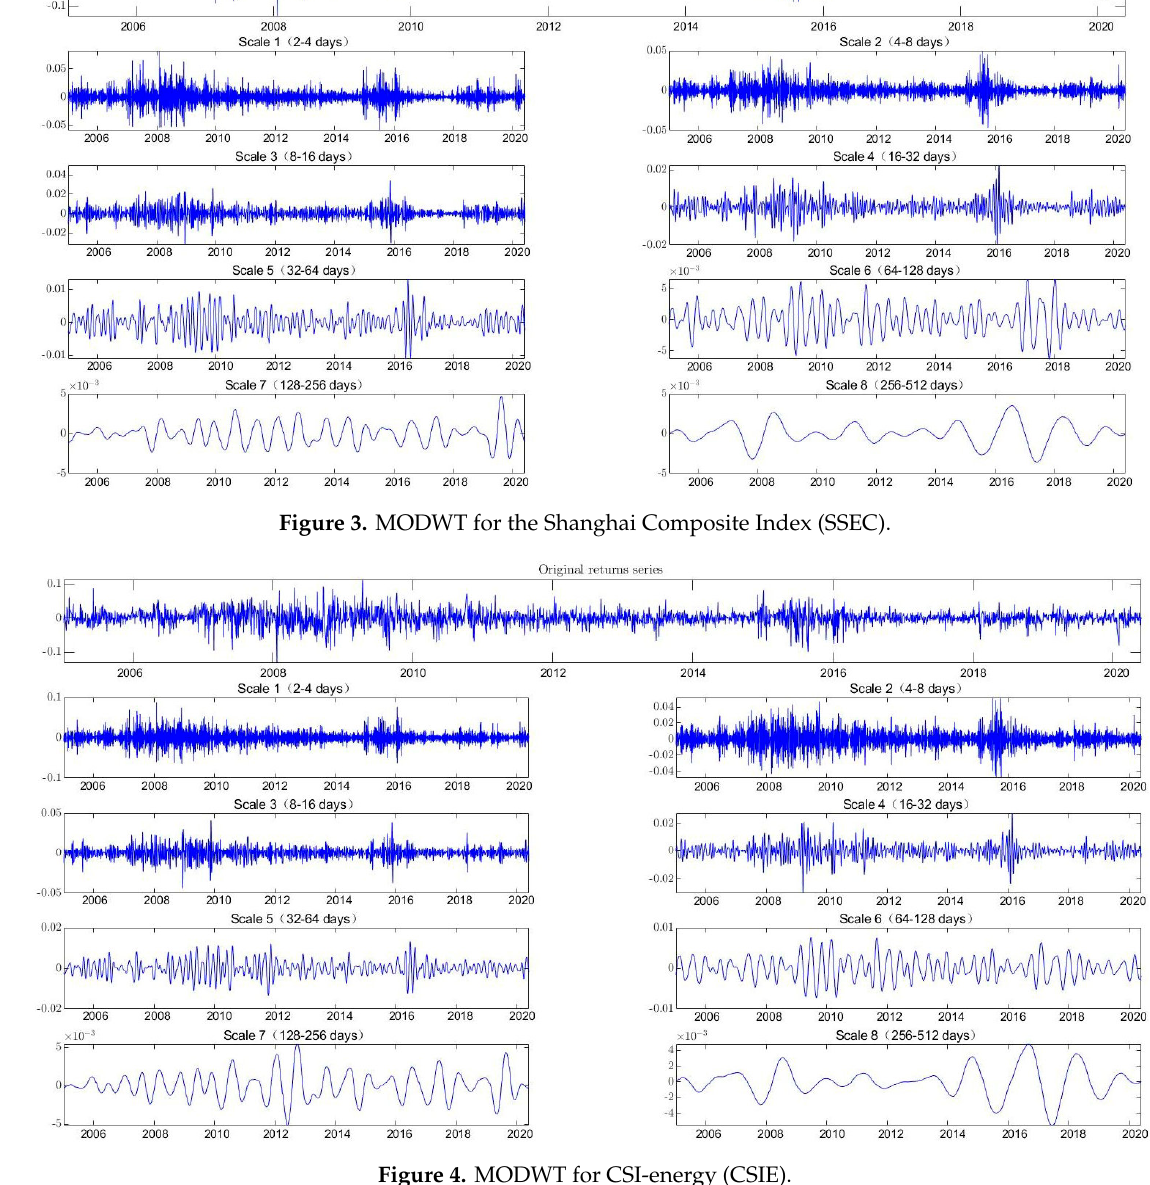
Figure 4. MODWT for CSI-energy (CSIE).